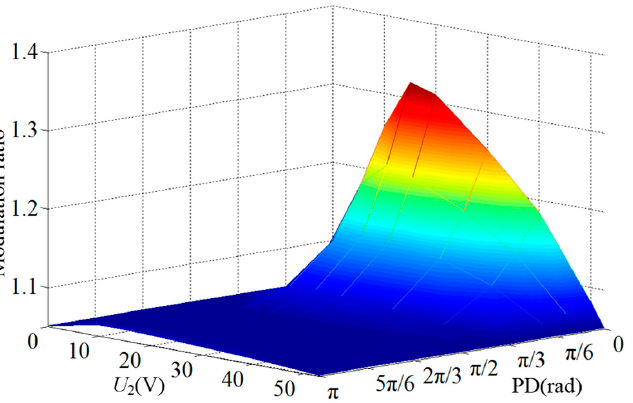
Figure 6. Modulation score layout of DFV − VSVPWM with method 2 (M2) under different phase differences.